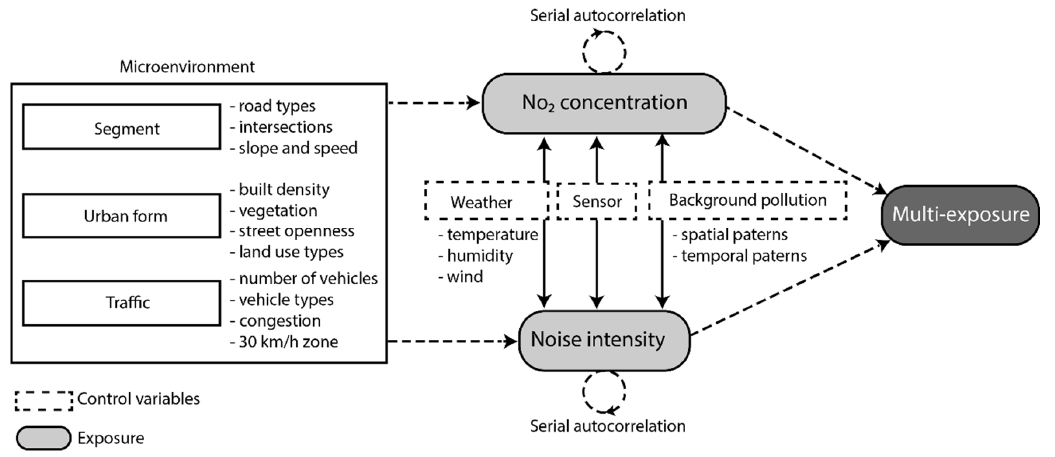
Figure 3. Conceptual framework.